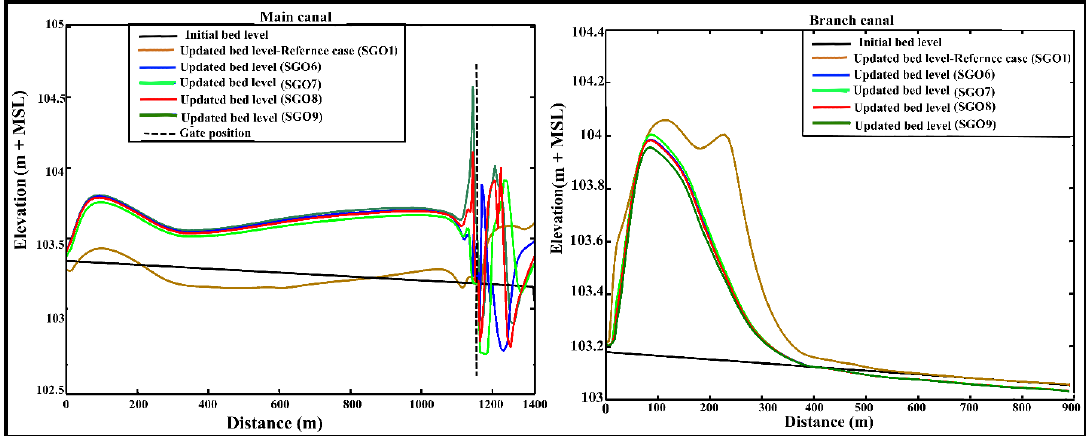
Figure 13. The bed level in scenarios with one gate opened.